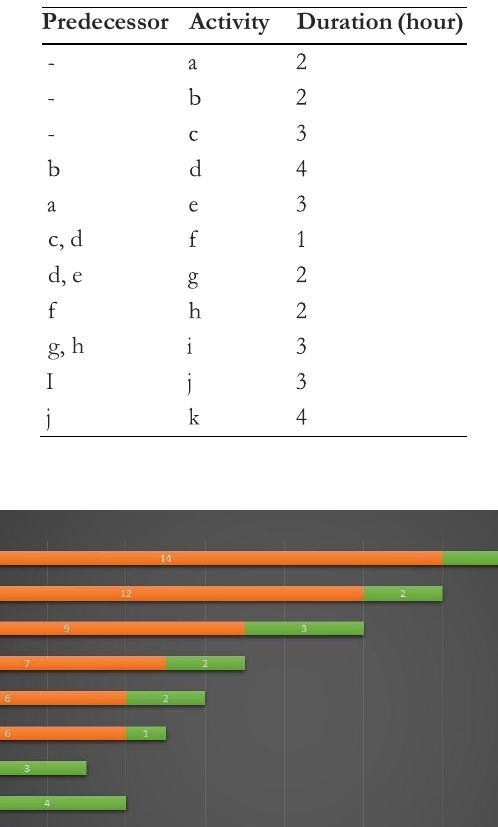
Table 1. Table for activities, predecessors and time durations.